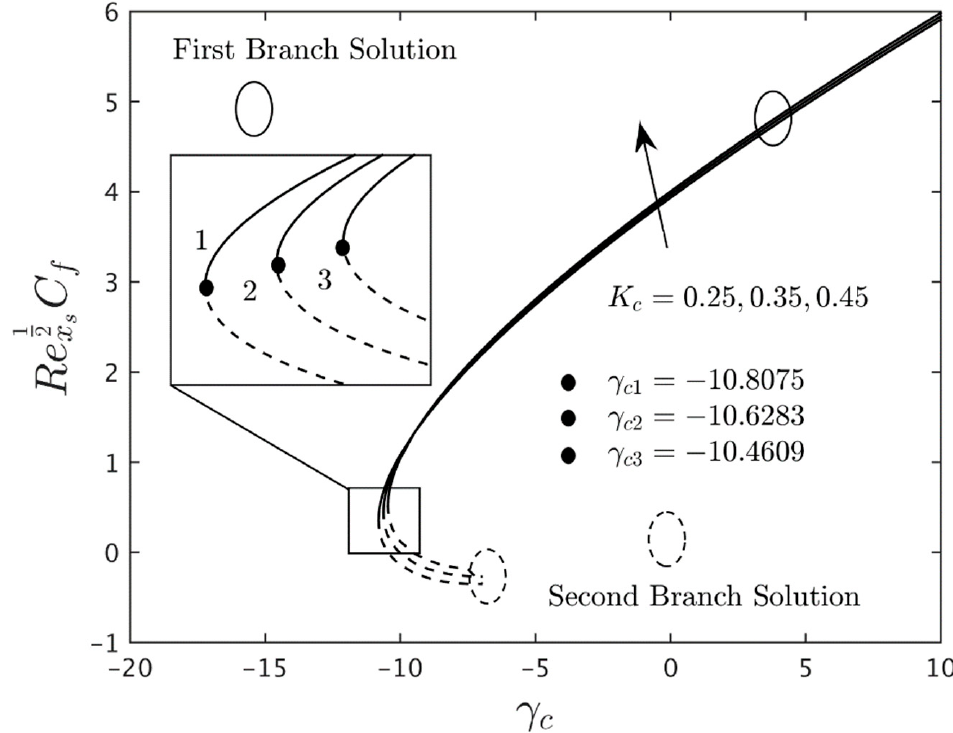
for the several values of c